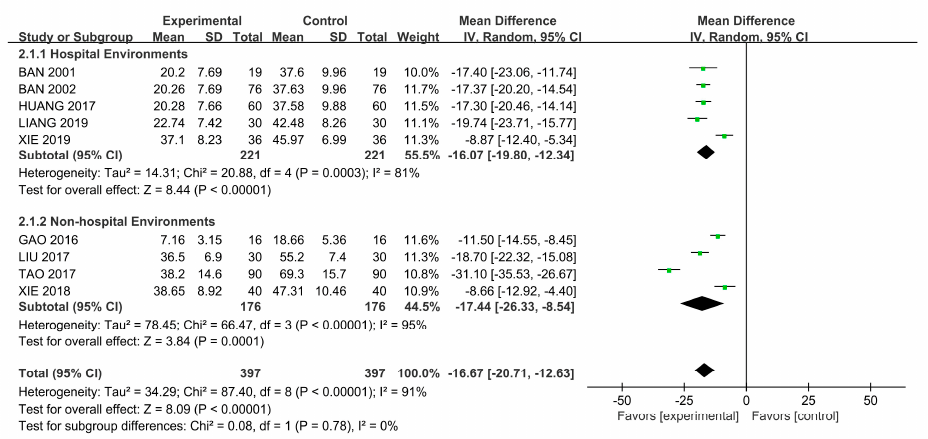
Figure 5. Effects on the rehabilitation outcomes.